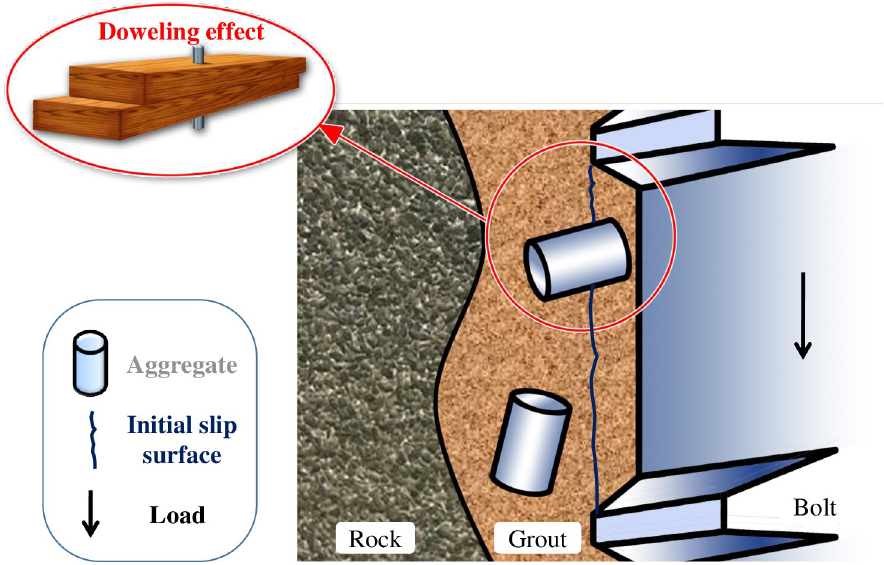
Fig 2. Working principle of mixing metallic aggregates into grout